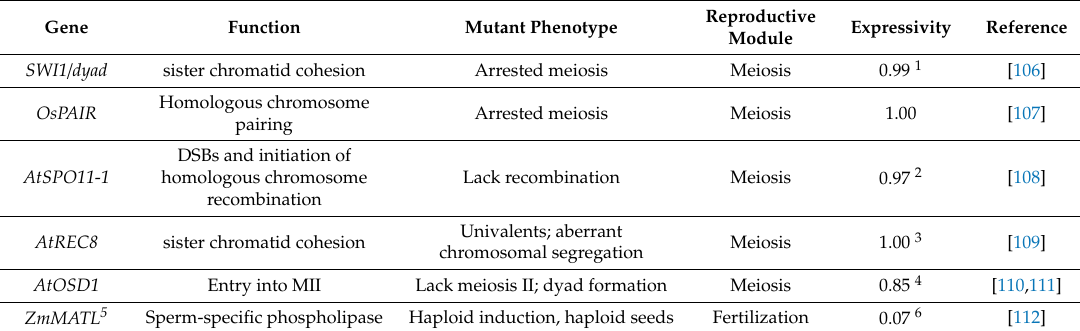
Common genes used to manipulate specific reproductive steps during gamete and seed